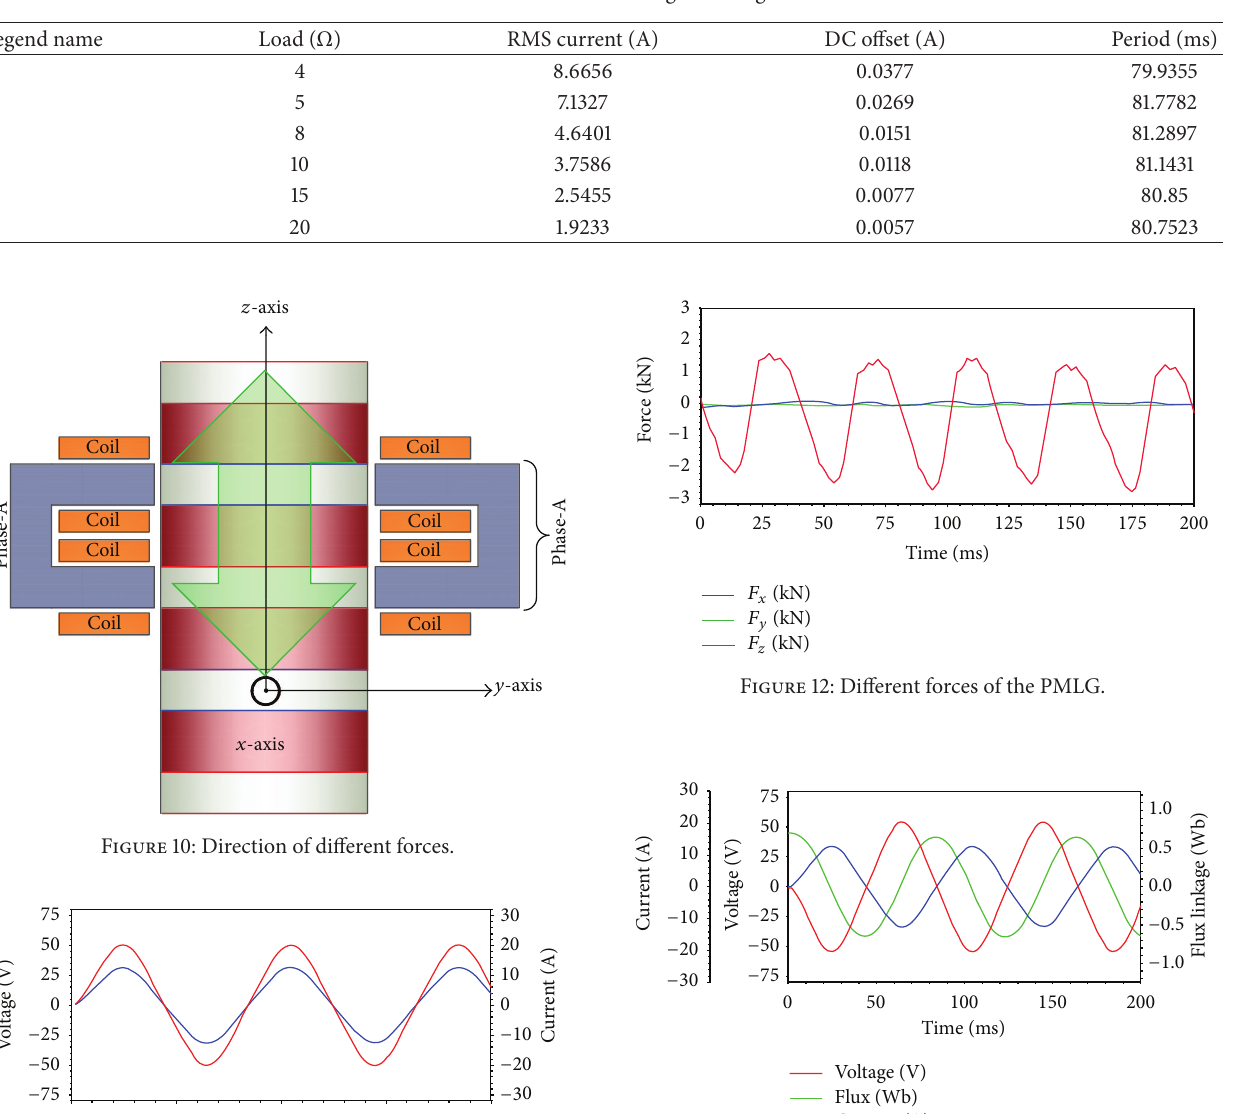
Table 2: Numerical values for legend of Figure 16.